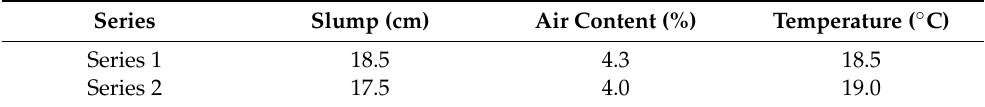
Table 7. Test results of fresh concrete.